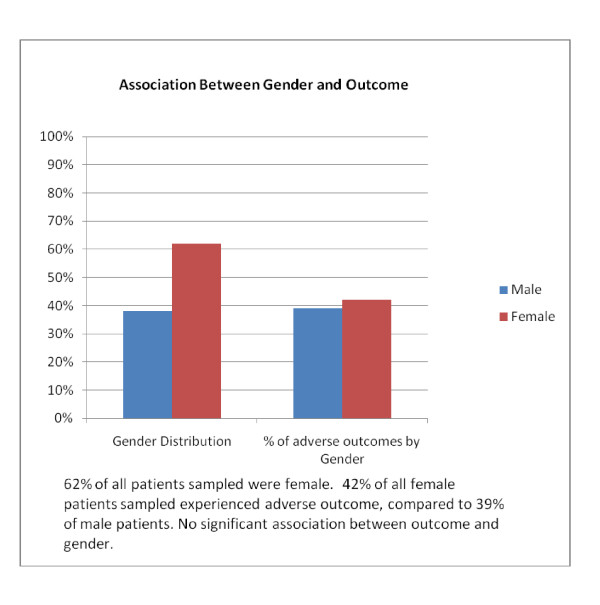
Gender against patient outcome.